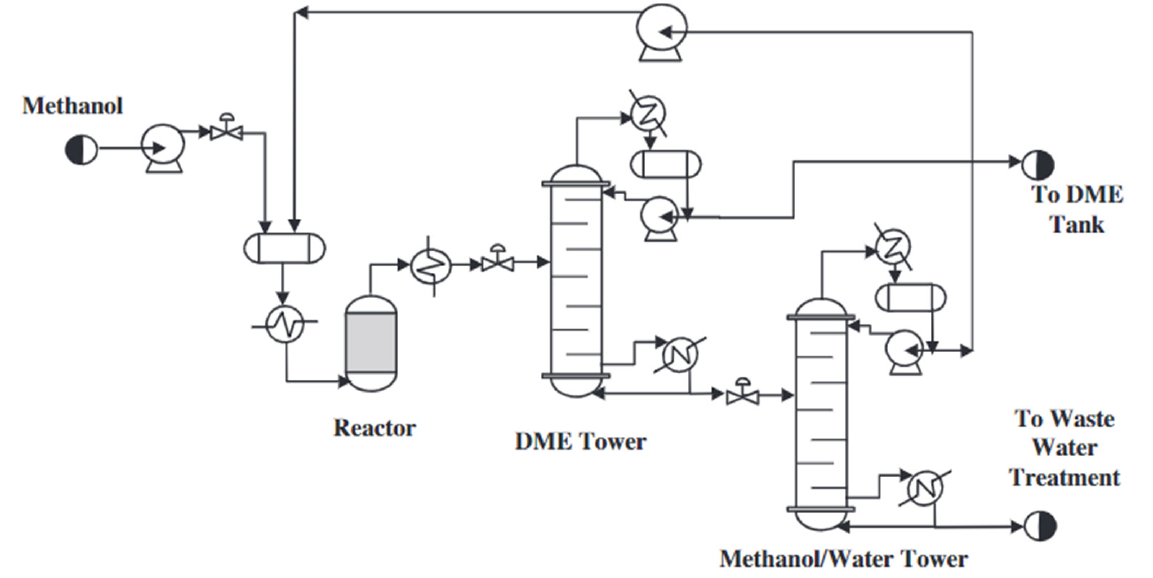
Figure 1. A figure of the indirect synthesis process installation. Reproduced with copyright permis- sion from [1].